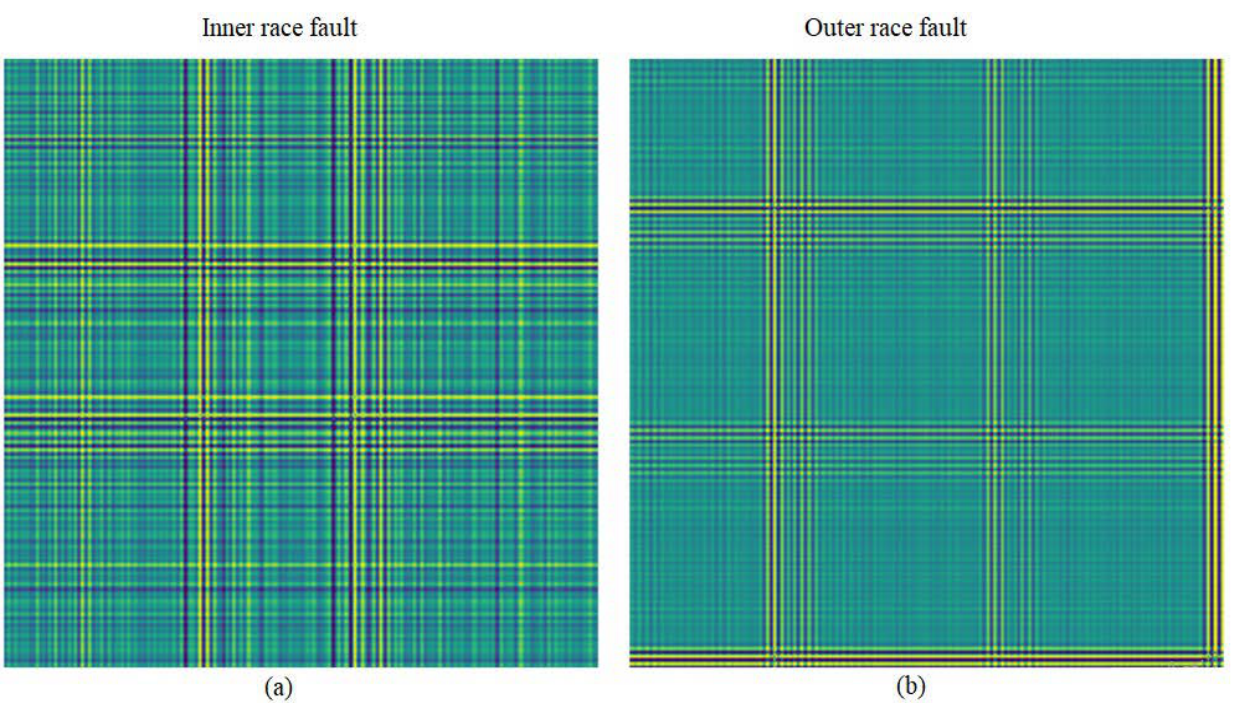
Figure 48. Gramian angular field (GAF) with Dense-Net patterns for recognition of the ( a ) inner race and ( b ) outer race bearing faults expressed by using [122].